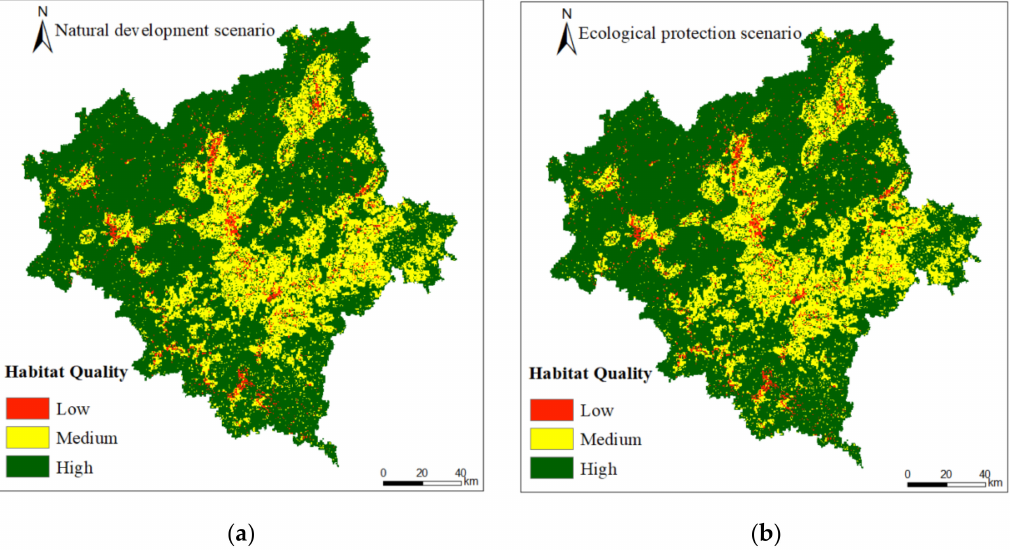
Figure 4. Spatial pattern of habitat quality in 2025 under ( a ) the natural development scenario and ( b ) the ecological protection